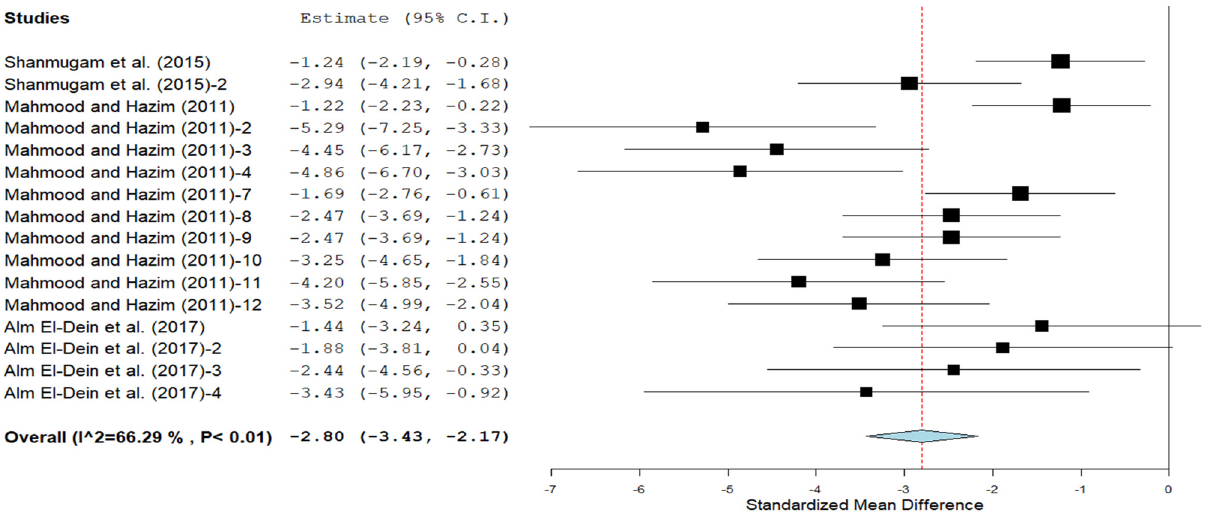
Figure 7: Impact of dietary zinc supplement on abnormal sperm percent. The thick vertical line is the line of no e ff ect ( i.e. SMD = 0 ) . Points to the left of this thick vertical line connote a decrease in abnormal sperm percent, while points to the right depict an increase in abnormal sperm percent. The dotted line shows the overall SMD. The result is considered signi fi cant the 95% CI of the overall SMD did not include